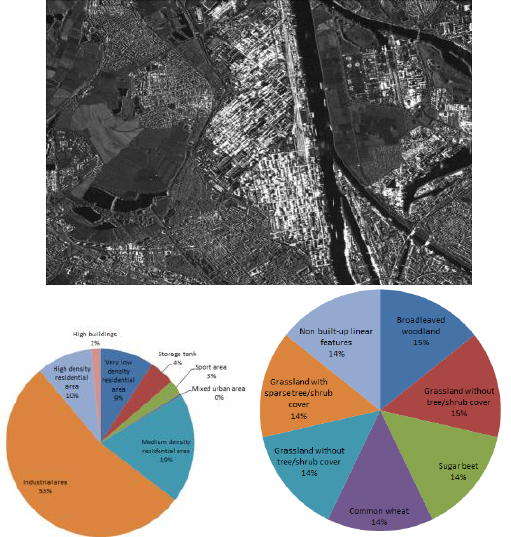
Figure 1: Distribution of the land use and land cover categories of the TerraSAR-X scene found using (Left) the SVM and (right) LUCAS data.